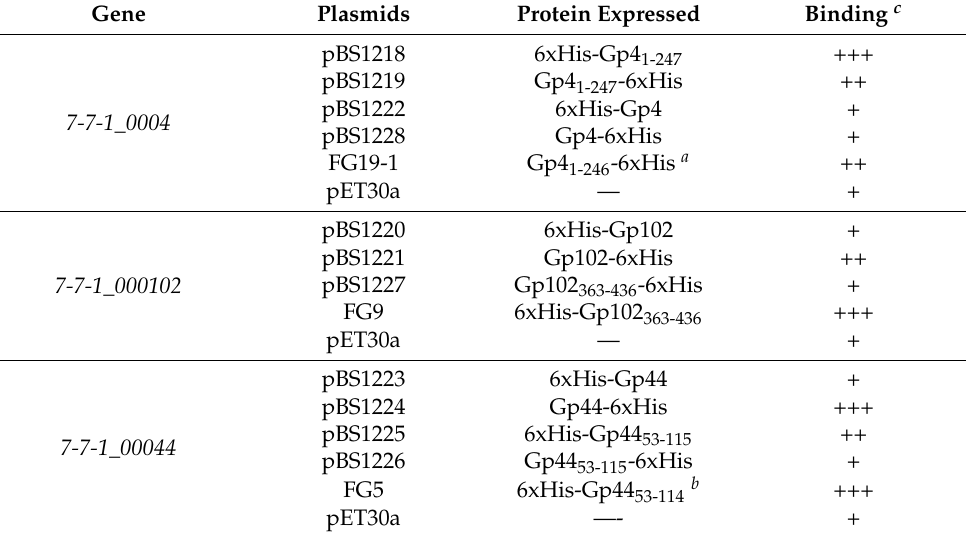
Table 4. Confirmatory RBP screen binding